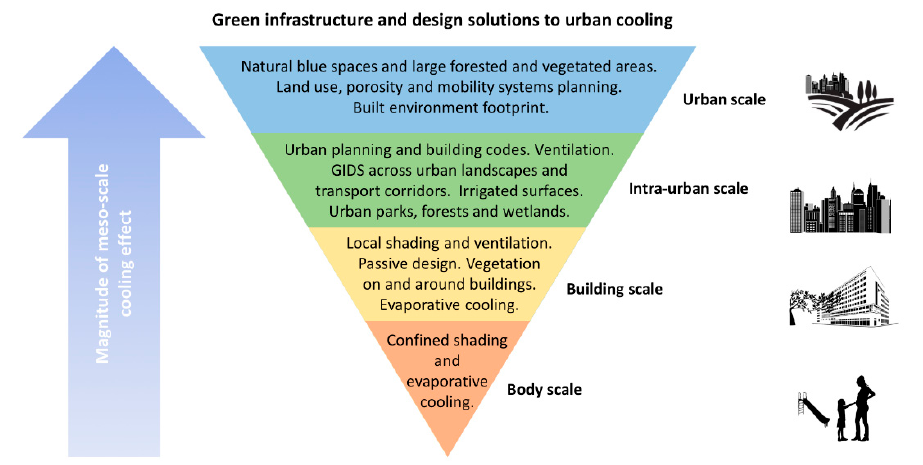
Figure 3. Application of GIDS within the urban fabric (figure by author).